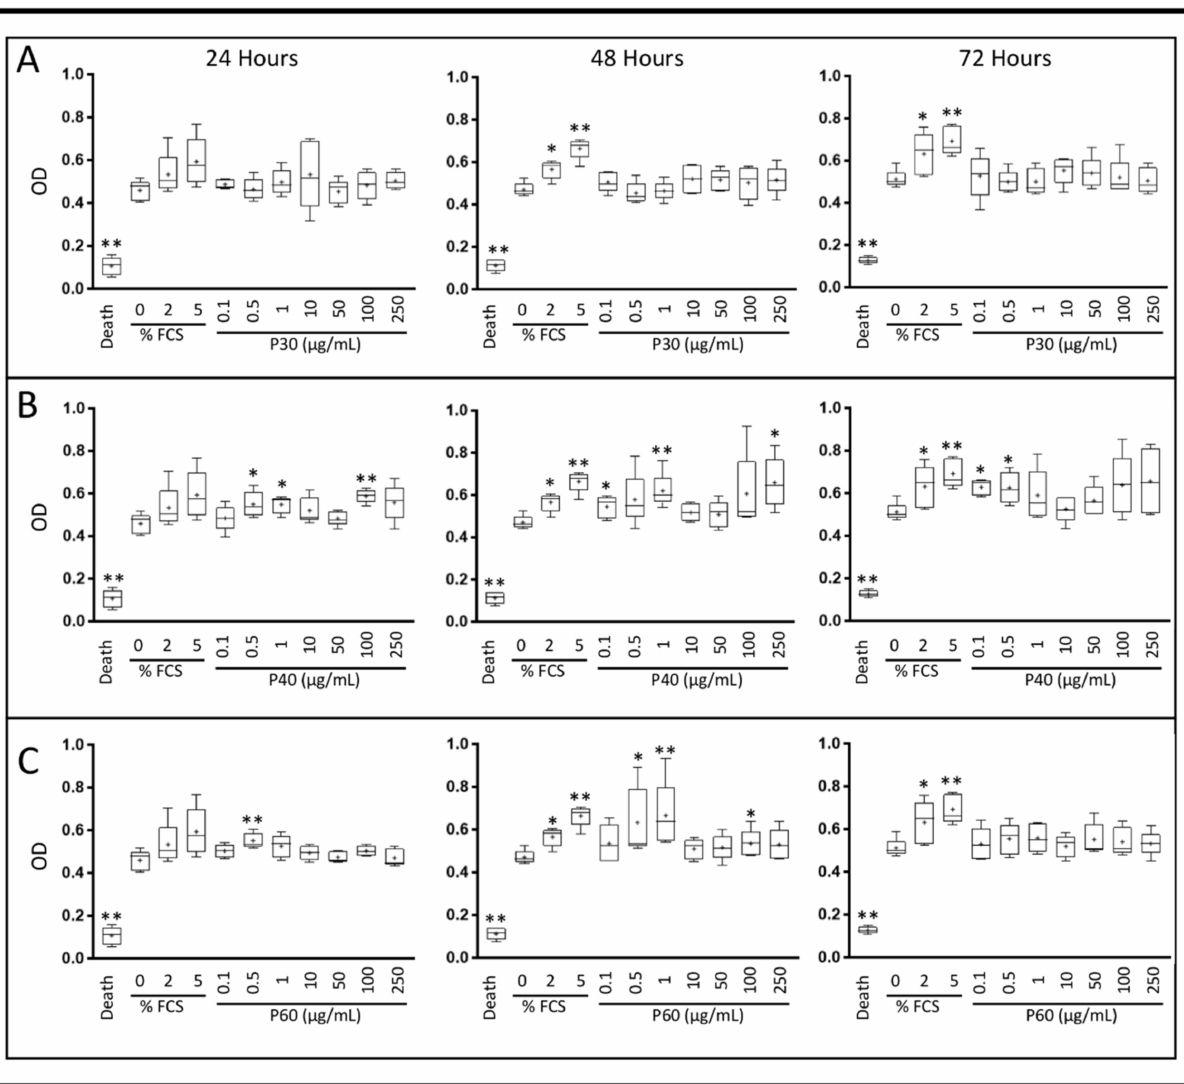
Figure 3. Effect of Promerim ® hydrolysates on the viability and proliferation of human articular chondrocytes. Human articular chondrocytes at P2 and 80% confluency were treated in the absence of FCS, with 0.1, 0.5, 1, 10, 50, 100 or 250 µ g/mL Promerim ® 30 ( A ), 40 ( B ) and 60 ( C ) for 24, 48 or 72 h in hypoxia. Controls with 0%, 2% and 5% of FCS, and a positive control of 100% cell death (Triton-induced death) were performed. Formazan levels, which are correlated with the viability and proliferation, were measured in the media after 24, 48 or 72 h of treatment. Results are summarized in box plots ( n = 5) showing the mean (cross) and the median (line) of optical density (OD). Statistical analyses were performed using the Mann–Whitney test (* p < 0.05; ** p < 0.01) compared with the 0% FCS